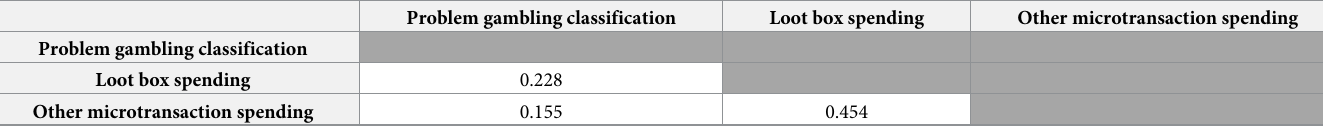
Table 5. Correlation matrix for Spearman rank correlations between problem gambling classification, loot box spending, and other microtransaction spending.